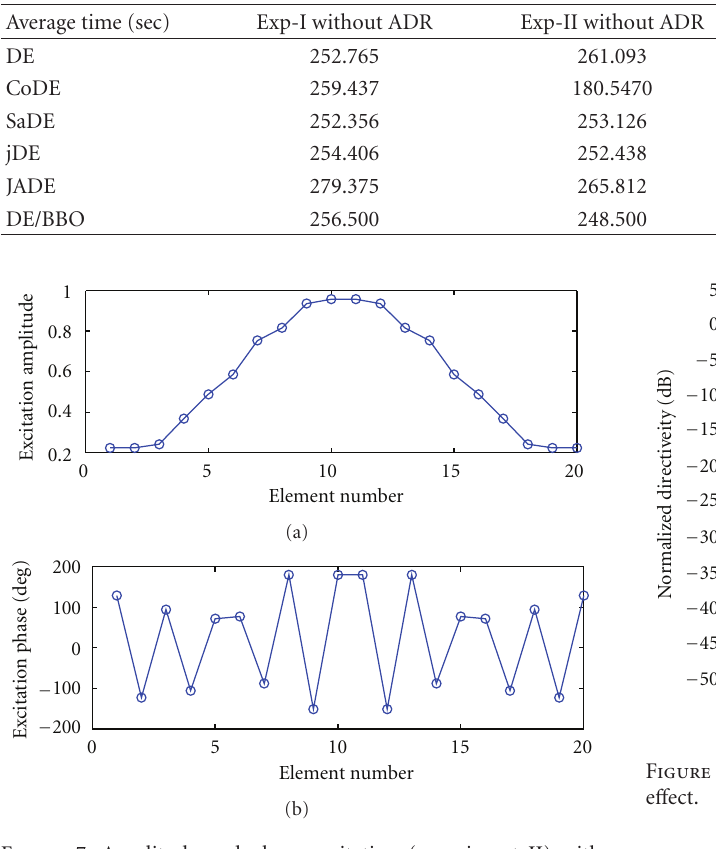
Figure 7: Amplitude and phase excitation (experiment II) with coupling e ff ect.